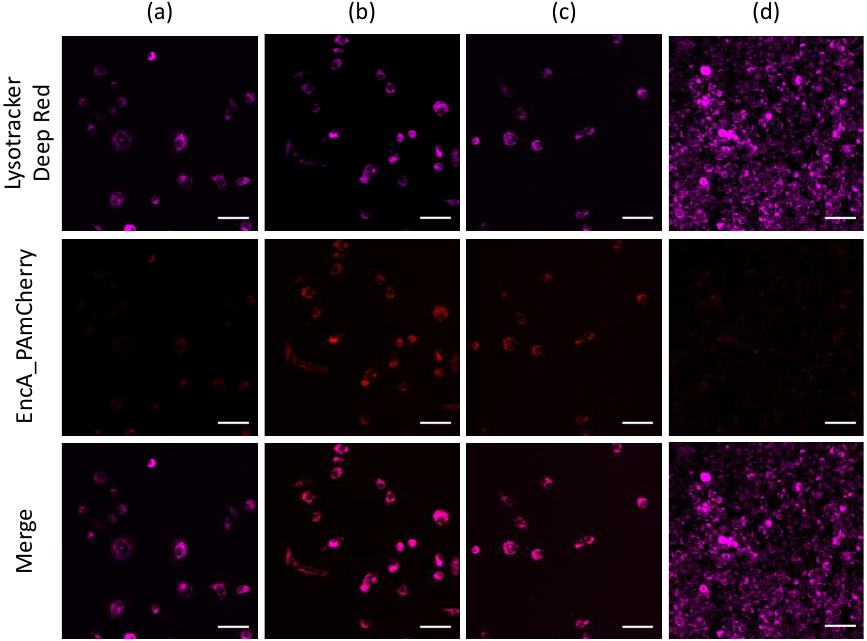
Figure 4. Confocal imaging of RAW 264.7 cells after ( a ) 15 min, ( b ) 1 h, ( c ) 2 h and ( d ) 24 h of incubation with isolated EncA_PAmCherry. RAW 264.7 cells were imaged after irradiation with 405 nm laser for 30 s followed by 561 nm excitation of PAmCherry label (red fluorescence signal). Lysosomes were stained with LysoTracker Deep Red dye (purple fluorescence signal). Laser scanning confocal microscopy, Nikon Eclipse Ti2 and scale bars are 50 μm.